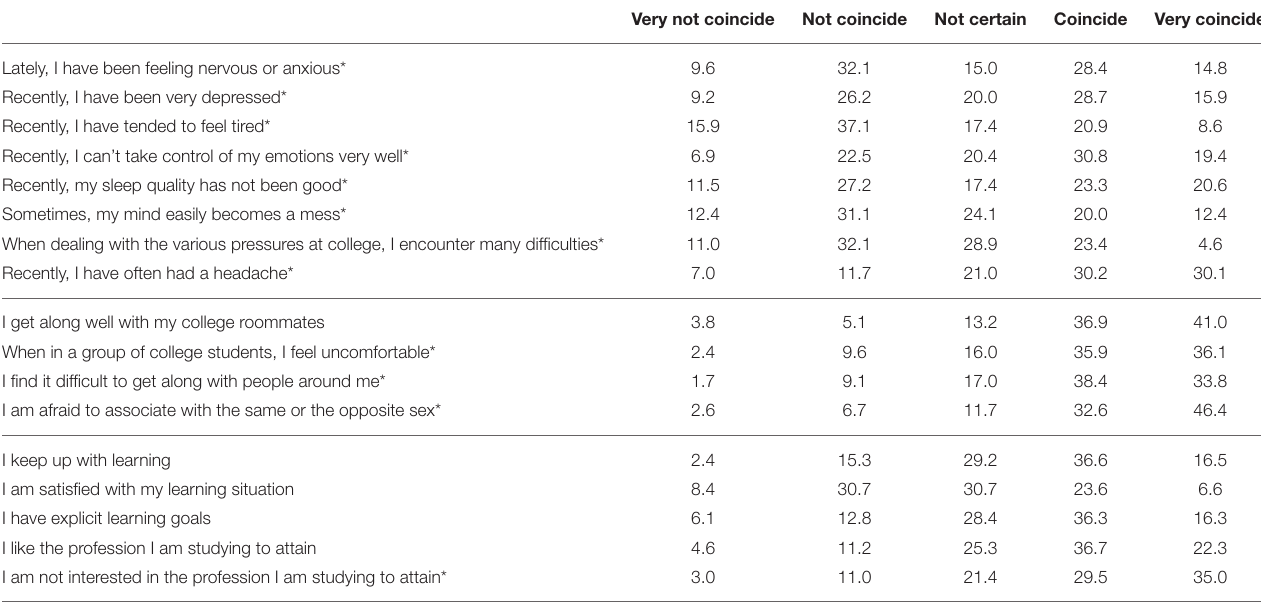
TABLE 1 | Three dimensions of college adaptation and all items’ proportion distribution (%).